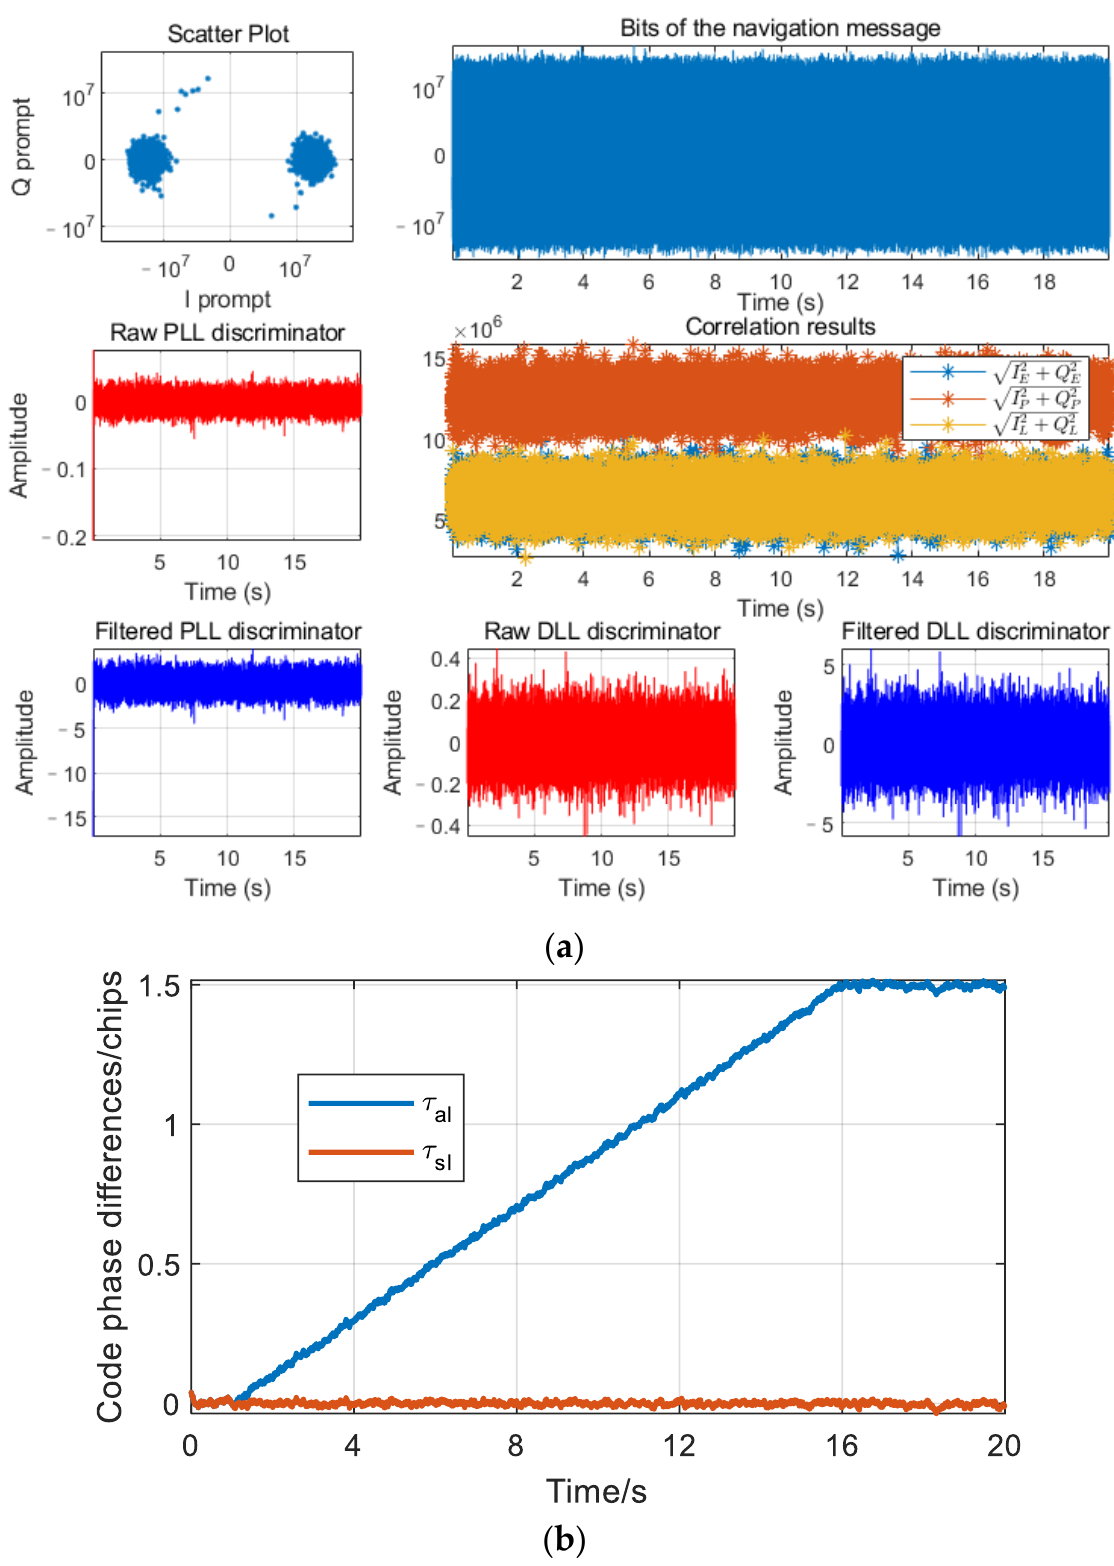
= 50 dBHz, D = 1 ). ( a ) Obtained results of soft- Figure 16. Results of the proposed strategy ( C/N Figure 16. Results of the proposed strategy (C/N 0 = 50 dBHz, D = 1). ( a ) Obtained results of 0 software receiver; ( b ) Code phase ware receiver; ( b ) Code phase difference.